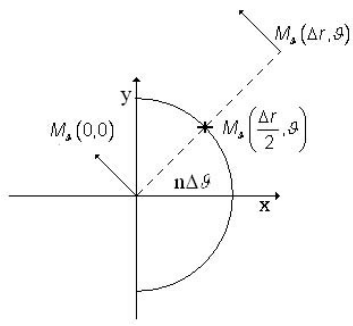
Figure 7: component of M between center and next